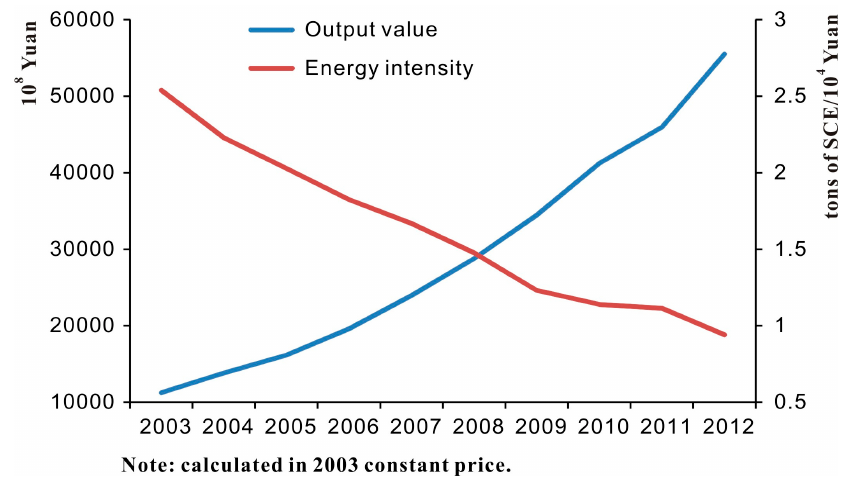
Figure 4. The output value and energy intensity of industrial sector 2003–2012.